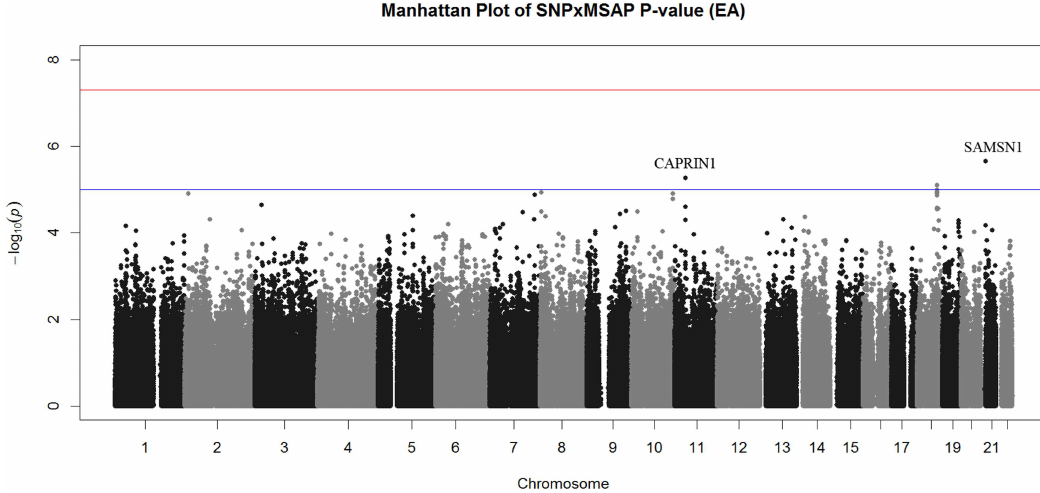
Fig 2. Manhattan Plot of Interaction P-values for EA GWIS. Manhattanplot of interaction P-values for the EA GWIS. Thoughno interactionsachievedgenome-wide significance (red line) interactions on chromosome 11 ( CAPRIN1 ), 18, and 21 ( SAMSN1 open chromatinregion)exceededthe suggestivesignificancethreshold (blue line). https://doi.org/10.1371/journal.pone.0173880.g002 covariates are given in Table 1 . A total of 756,588 SNPs with a MAF > 0.05 converged in the AA model and a total of 674,795 SNPs with MAF > 0.05 a converged in the EA model. The